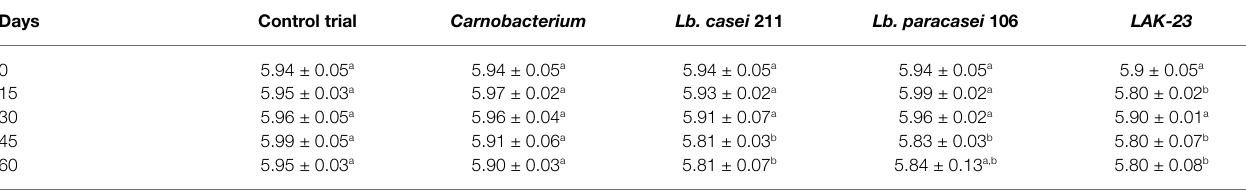
TABLE 4 | pH evolution in cold-smoked sea bass stored at 6 ± 2 ° C with and without LAB starter cultures added. Days